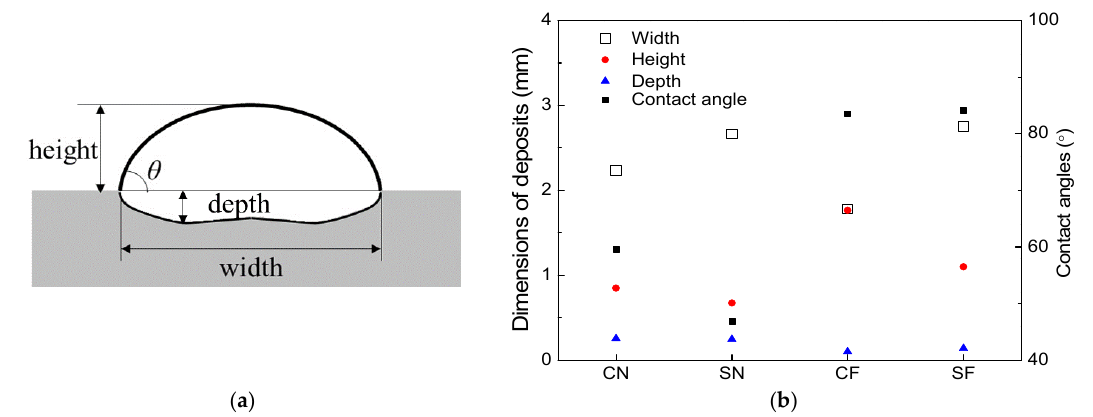
Figure 6. Dimensions of deposits made with four different conditions. ( a ) Definition of geometric parameters; ( b ) Dimensions of deposits for different conditions.